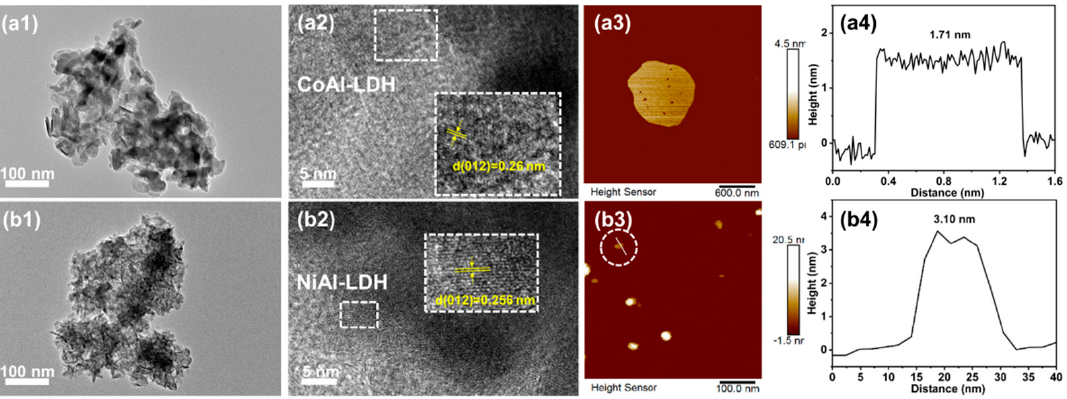
Figure 2. TEM and HRTEM images of CoAl-LDH ( a1 , a2 ) and NiAl-LDH ( b1 , b2 ); AFM images and the corresponding height profiles of CoAl-LDH ( a3 , a4 ) and NiAl-LDH ( b3 , b4 ). The surface areas and pore size distributions of CoAl-LDH and NiAl-LDH were further characterized by with Brunauer–Emmett–Teller (BET) N 2 -sorption measurement. Figure 3a,b show the N 2 adsorption–desorption isotherms and pore diameter distribution curves of CoAl-LDH and NiAl-LDH, respectively. Both CoAl-LDH and NiAl-LDH exhibited typical IV isotherms, implying the existence of a mesoporous pore structure [61,62]. The BET specific surface area of NiAl-LDH was 174.57 m 2 g − 1 , which was larger than the value of 51.47 m 2 g − 1 for CoAl-LDH. The Barrett–Joyner–Halenda (BJH) method was used to estimate the pore diameter distributions of the samples. The average pore diameters of CoAl-LDH and NiAl-LDH according to the BJH method were, respectively, 34.66 and 10.42 nm.